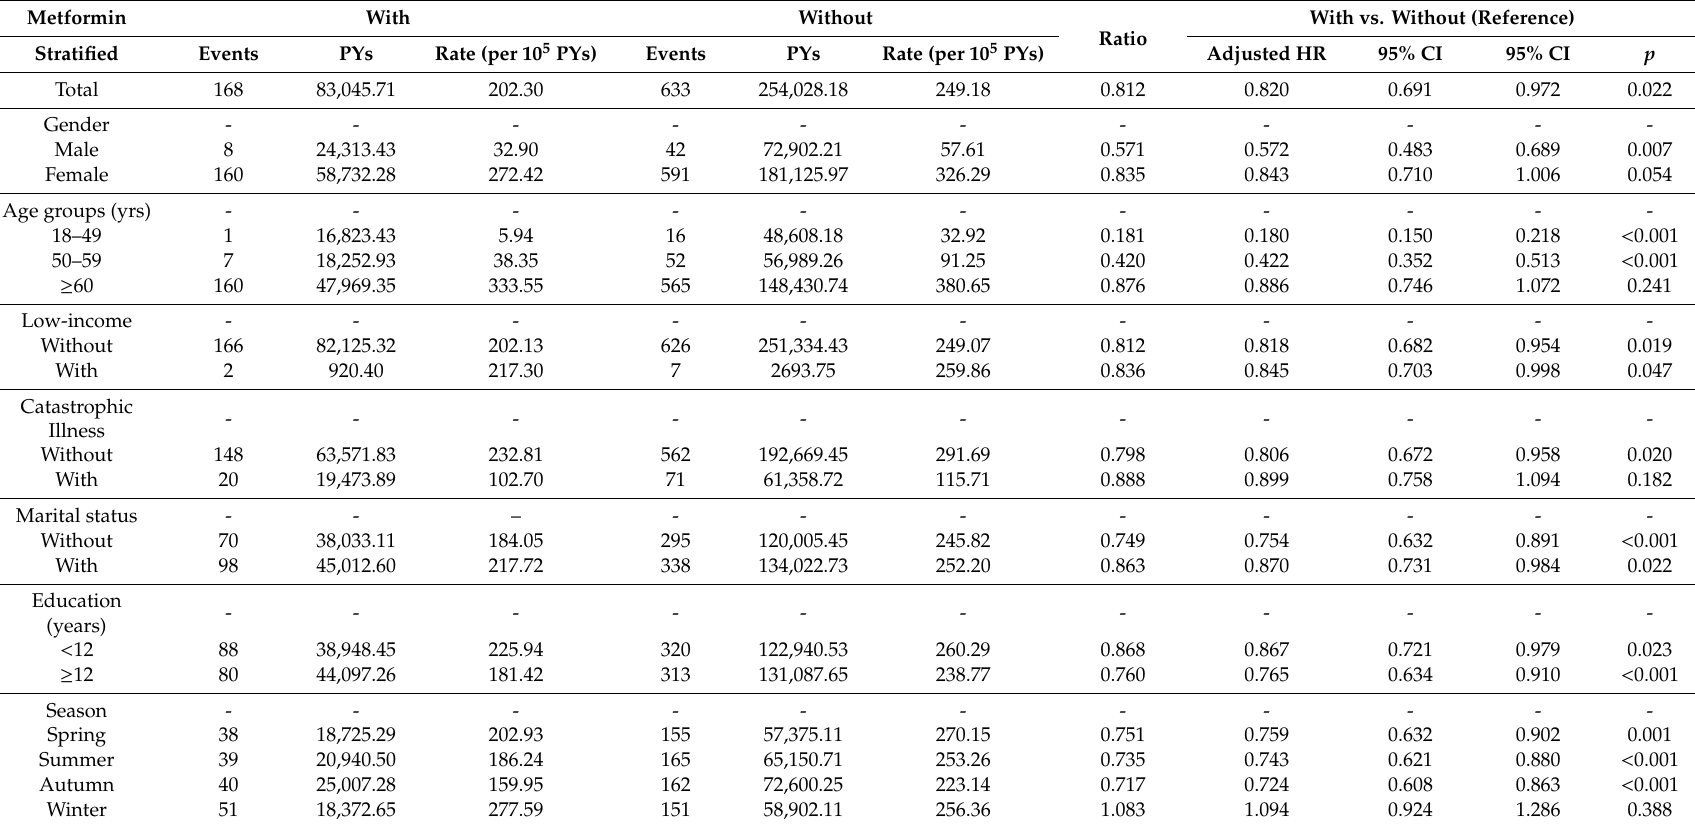
Table 4. Factors of osteoporosis stratified by variables listed in table by using Cox